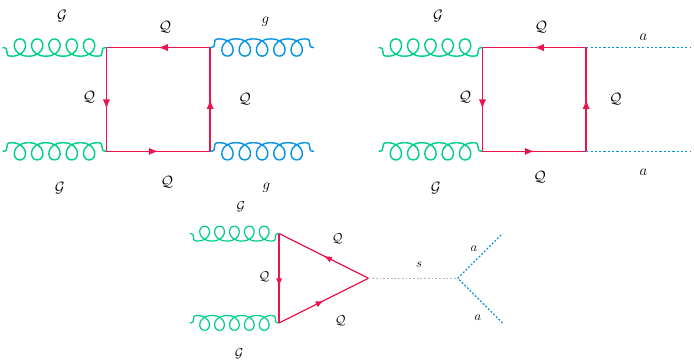
Figure 4 . Some Feynman diagrams for dark glue-ball decay into gluons and axions. Analogous diagrams with heavy leptons L or vectors W in the loops are not